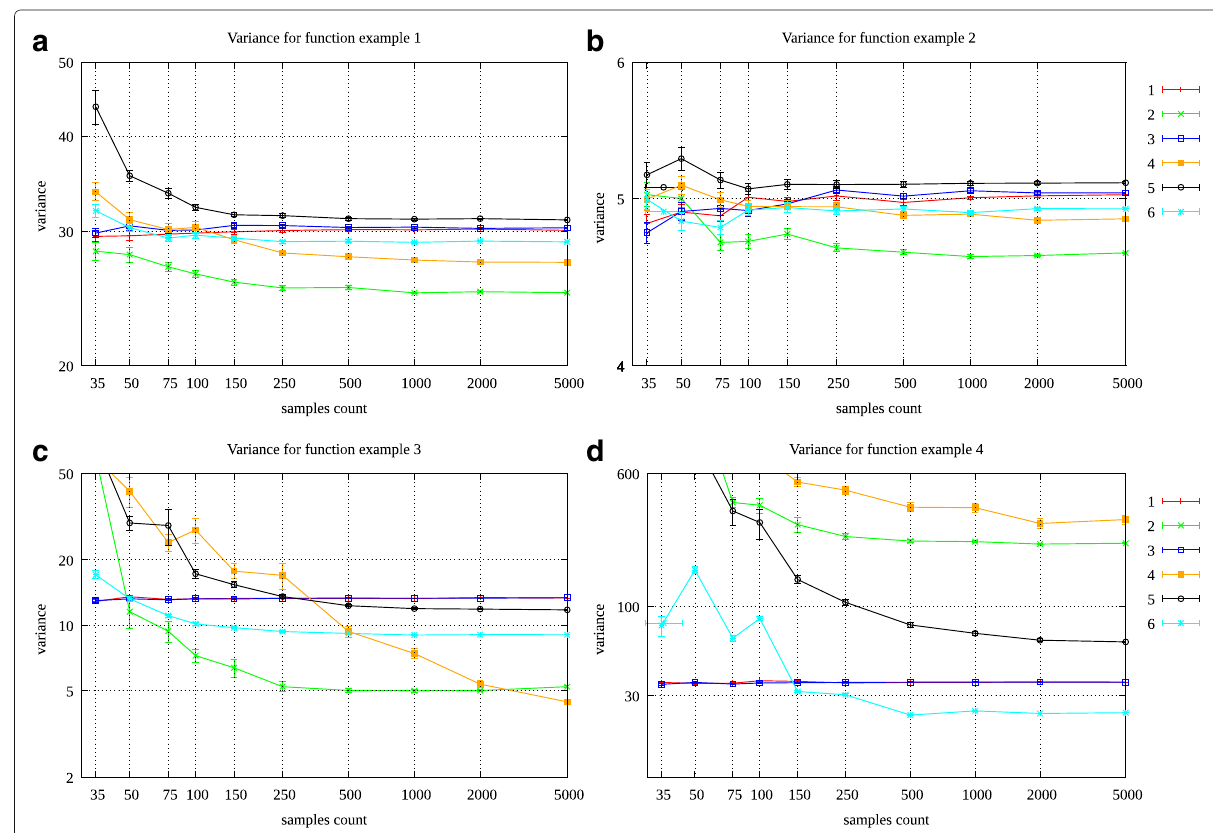
Fig. 2 The variance for the estimators for adaptive sampling for different samples count and unit cost of sampling techniques. a Example 1, b example 2, c example 3, and d example 4. Notation of lines 1 to 6 used in charts follows the order of row in Table